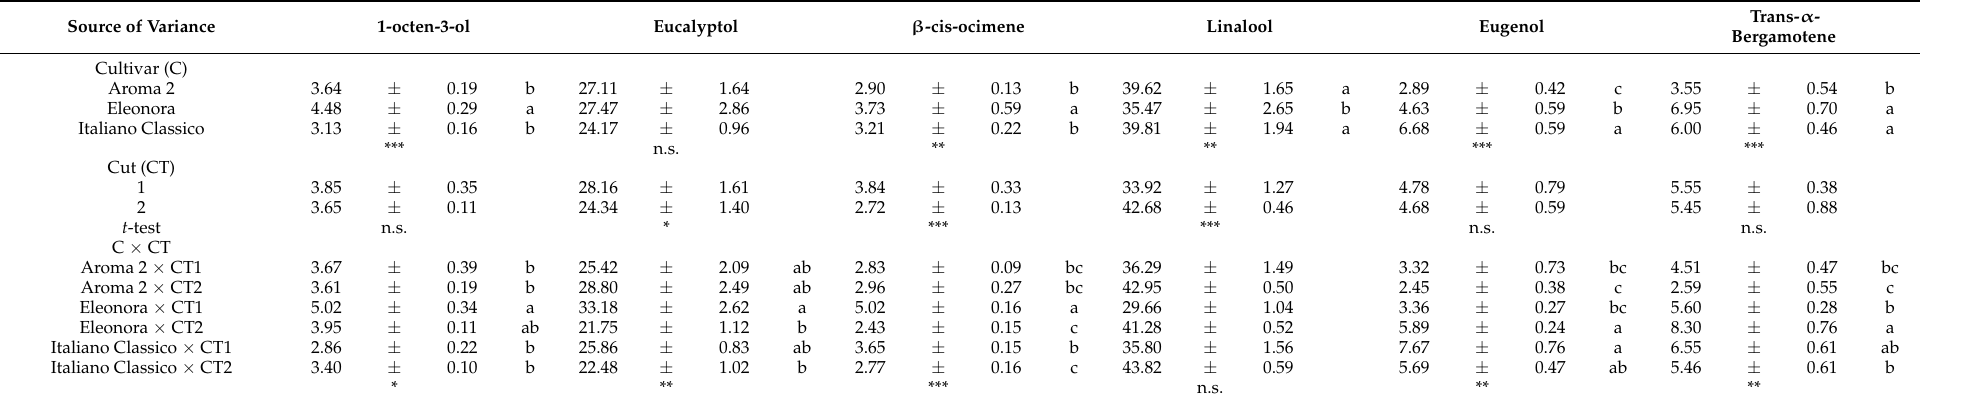
Table 3. Effect of cultivar and cut on aroma profile (%) of